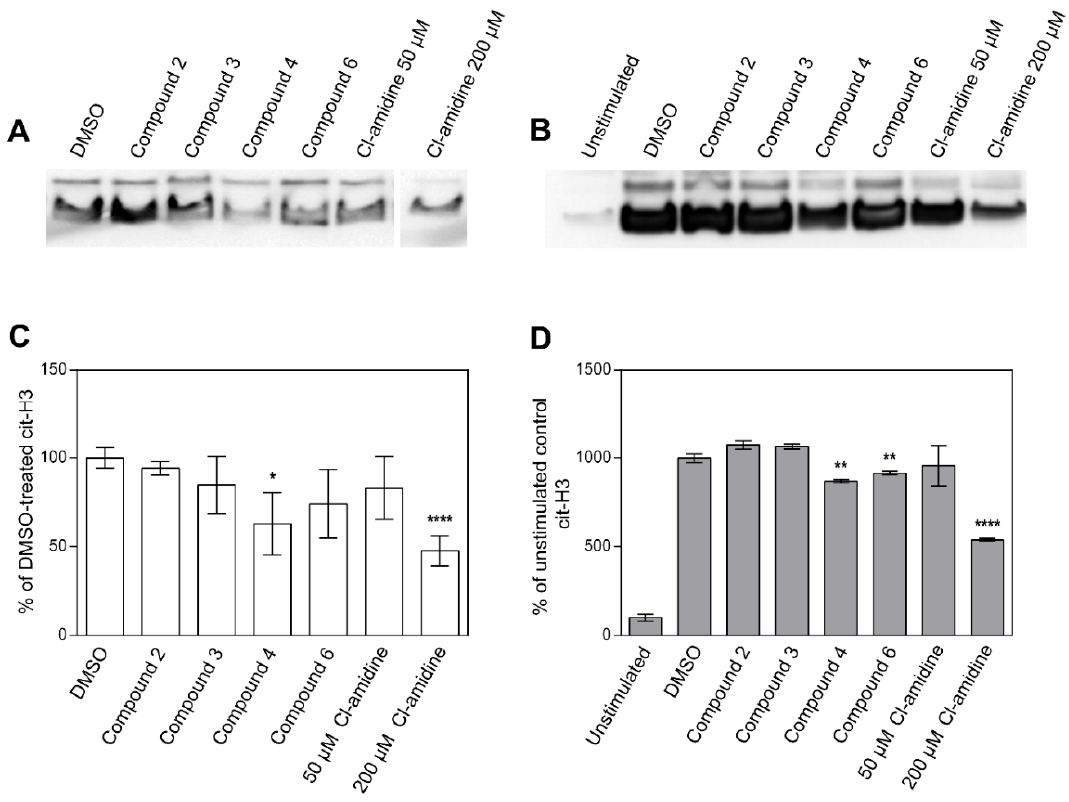
Figure 4. Inhibition of histone H3 citrullination in vitro ( A , C ) and in isolated human neutrophils ( B , D ). ( A ) GST-PAD4 was pre-incubated with DMSO alone, 50 μ M of candidate compounds or 50 μ M and 200 μ M of Cl-amidine in the presence of 10 mM CaCl 2 and 0.5 mM DTT for 30 min prior